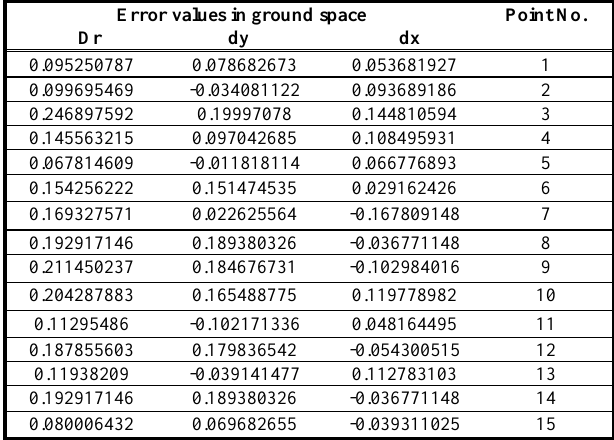
Table 2. Error values in the ground space for each point According to Table 2, RMSE and STD values are calculated as 0.1608 and 0.0542 meters, respectively. Table 3 shows the error values in the image space for each of the points.